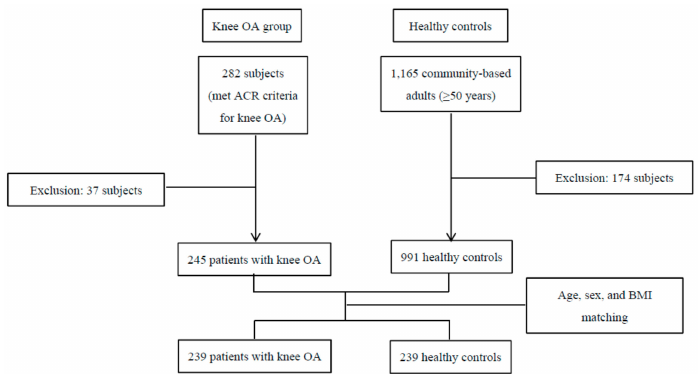
Figure 1. Subjects’ enrollment. OA, osteoarthritis; ACR, American College of Rheumatology; BMI, body mass